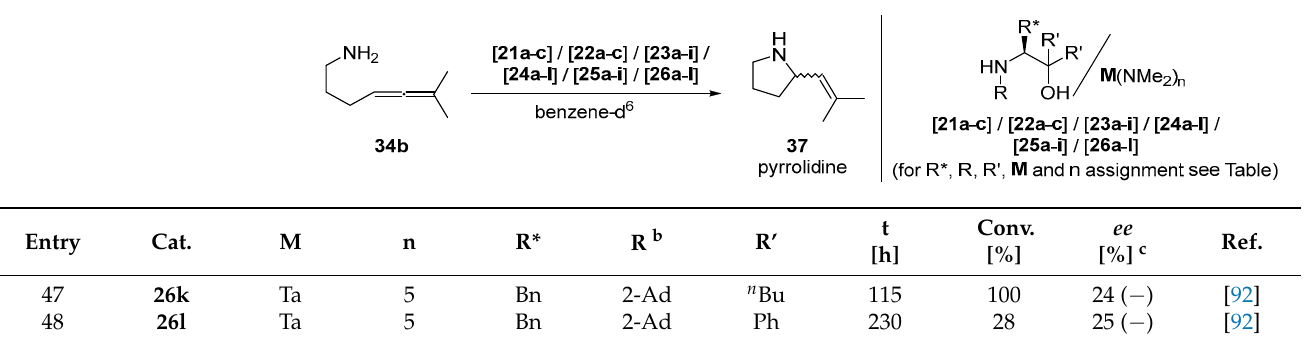
Table 6. Catalytic asymmetric hydroamination of 34b using chiral titanium 21a – c , 22a – c , 23a – i and Table 6. Cont.